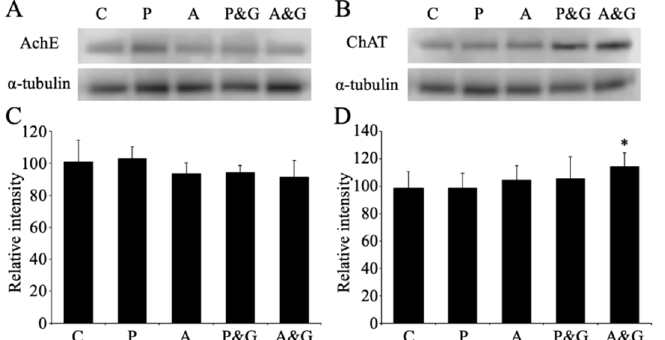
Figure 8. Images of Western blot of acetylcholinesterase ( A ) and choline acetyltransferase ( B ) after smart drug administration are shown. α -tubulin was used as a loading control. Densitometry analysis of the Western blot data of acetylcholinesterase and choline acetyltransferase are shown in ( C ) and ( D ), respectively. Data are expressed as mean ± standard deviation. Data are also shown as the relative intensity (100 = intensity of control value). C, P, A, P&G, and A&G represent the vehicle-treated control animals, piracetam-treated animals, aniracetam-treated animals, piracetam and α -GPC-treated animals, and aniracetam and α -GPC-treated animals, respectively. AchE: acetylcholinesterase; ChAT: choline acetyltransferase *: p < 0.05 compared with the